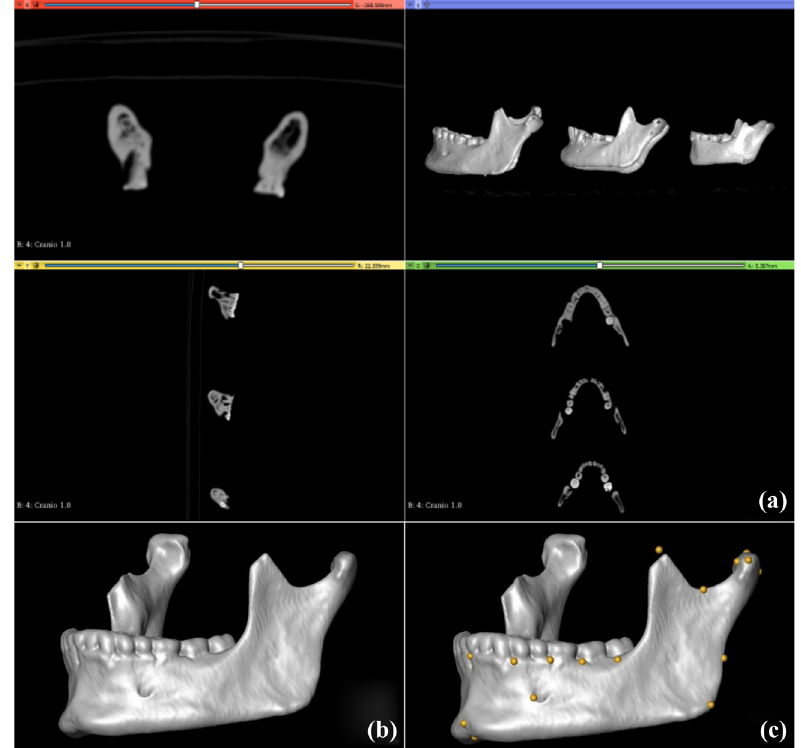
Figure 2: Visualisation of CT scan slices ( a ) , ensued by rendering ( b ) , and landmarking of individual specimens ( c ) . Note that C shows the location of present and estimated missing ( e.g., in the coronoid process )